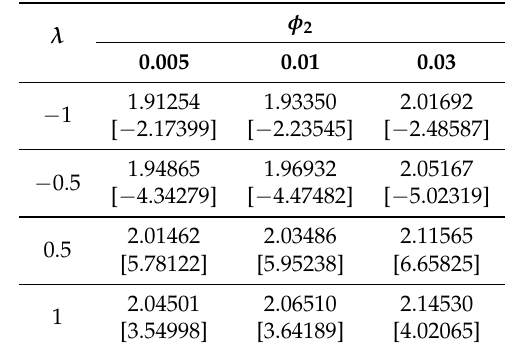
Table 10. The values of Re − 1/2 x Nu x for the opposing and assisting flow cases when φ 1 = 0.1 and Z = d = 0.5 ([] indicates the second solution).